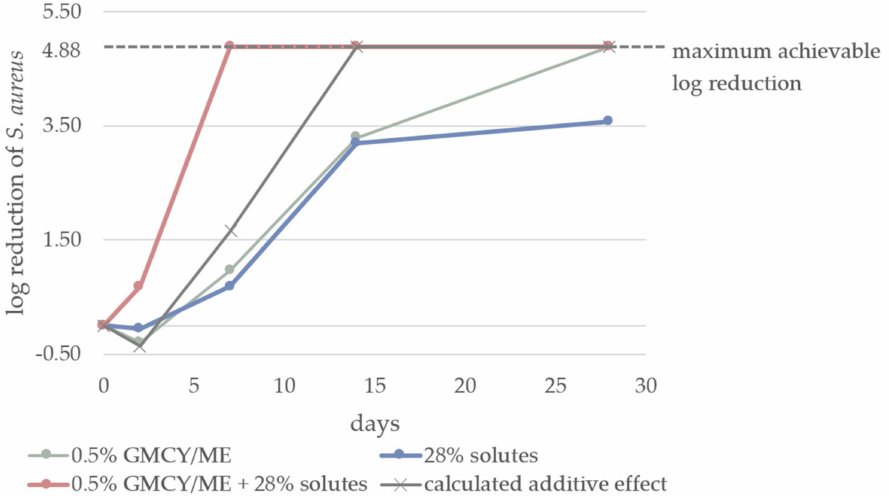
Figure 4. Plot of the log reductions in S. aureus in the o/w emulsion containing either 28% solutes, 0.5% Glyceryl Caprylate/Magnolia Officinalis Bark Extract or both systems in combination as well as the calculated additive effect, which results from the addition of the individual systems. The maximum achievable log reduction was 4.88;, therefore, the additive effect (if it exceeded this value) was set to